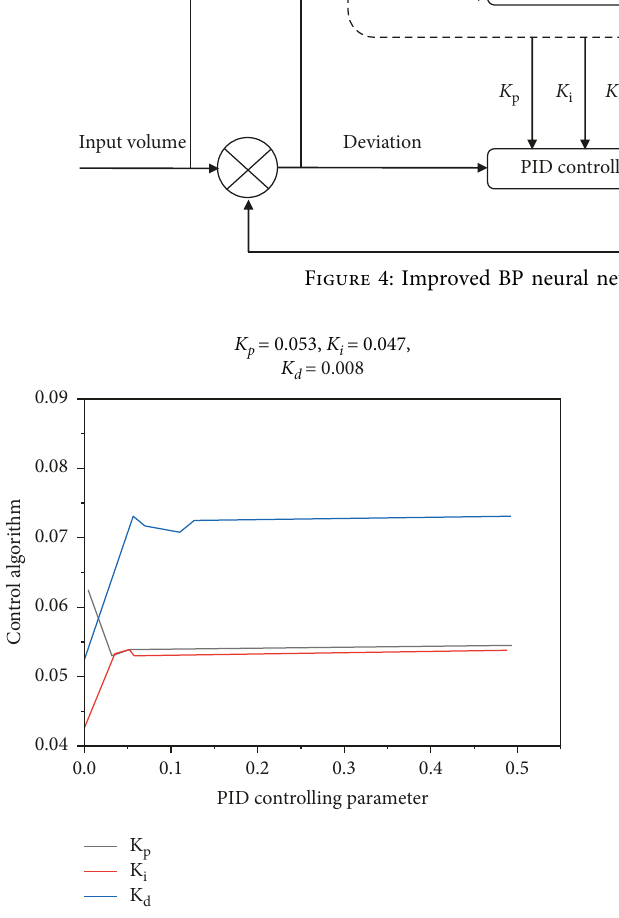
Figure 5: PID control parameter curve of three control algorithms.